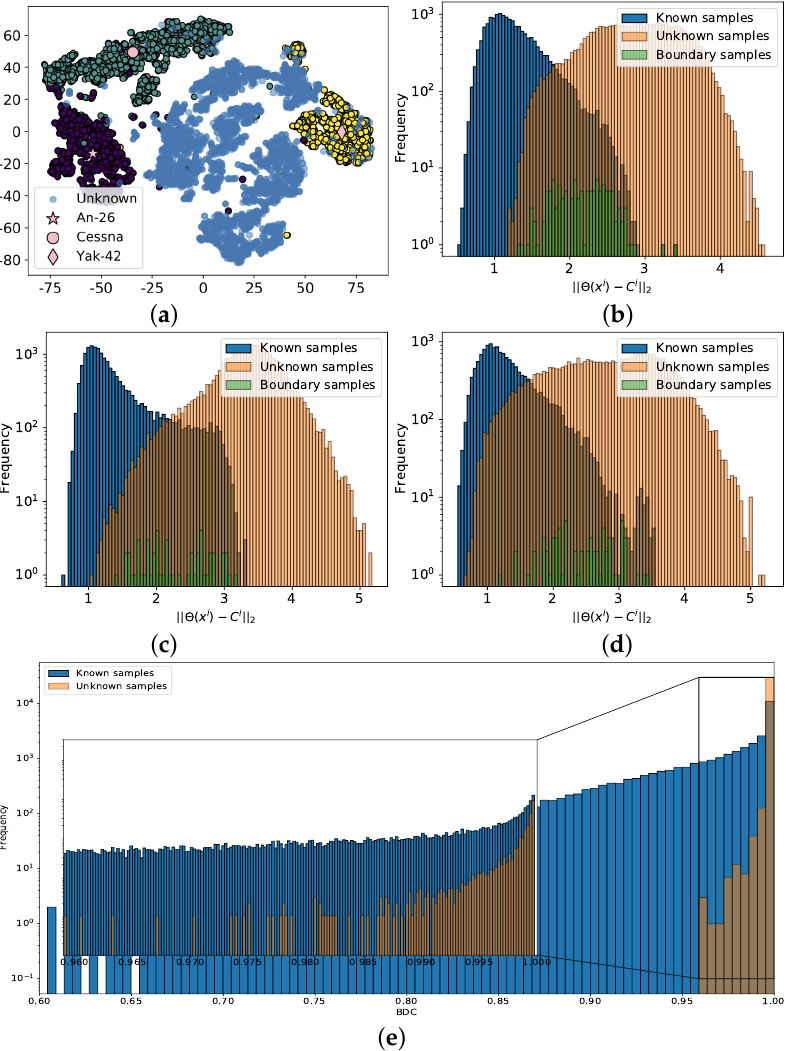
Figure 10. This figure shows the feature distribution, distance distribution, and BDC distribution under the BD_Ring model of the proposed method. Among them, ( a ) shows the feature distribution after dimension reduction visualization by t-SNE, and the legends show the feature center of three known classes; ( b – d ) show the distance distribution from the sample features of three kinds of known targets and unknown features to the feature center; ( e ) shows the BDC distribution of the known and unknown features; ( a ) Feature distribution; ( b ) An − 26; ( c ) Cessna; ( d ) Yak − 42; ( e ) BDC